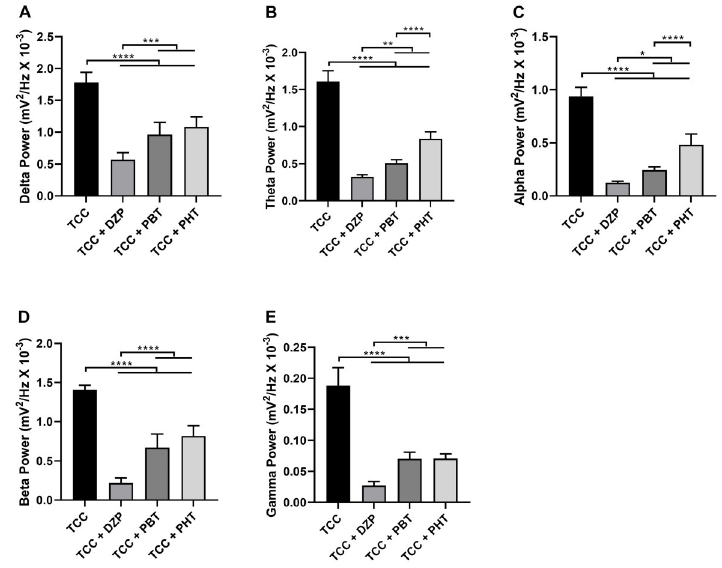
Figure 4. Quantitative linear frequency distribution of the brainwaves in animals submitted to TCC-induced seizures and treated with anticonvulsant drugs. A , Delta waves; B , theta waves; C , alpha waves; D , beta waves; and E , gamma waves. Data are reported as means ± SD (n=7 animals/group). *P o 0.05, **P o 0.01, ***P o 0.001, and ****P o 0.0001 (one-way ANOVA followed by Tukey ’ s test). TCC: thiocolchicoside; DZP: diazepam; PBT: phenobarbital; PHT: